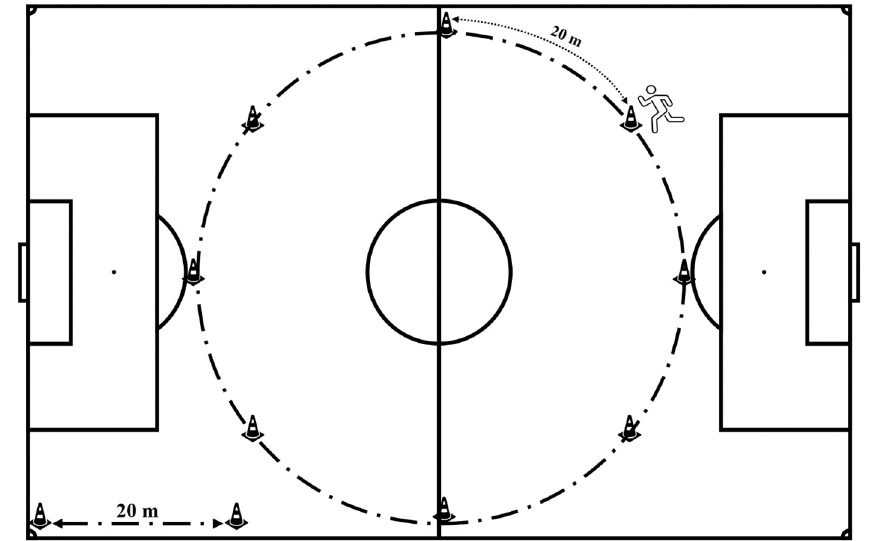
Figure 1. UEFA standard grass soccer pitch adapted for a constant-speed linear-running test.